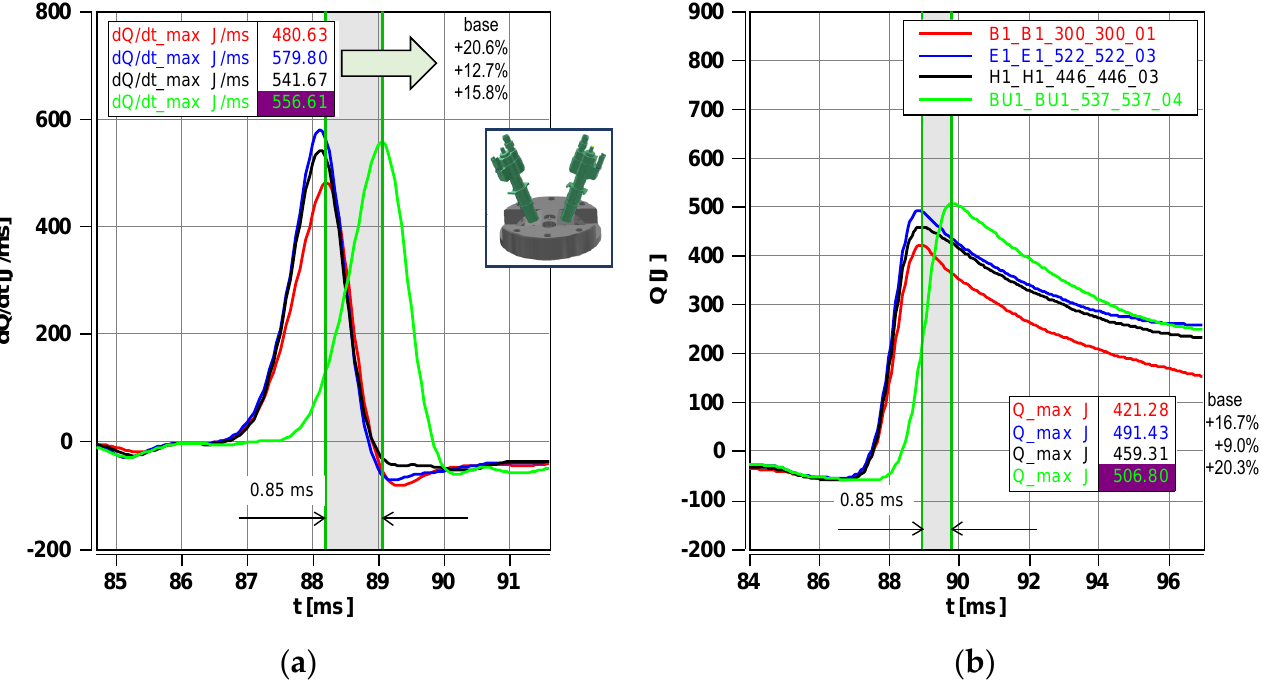
Figure 11. Combustion process indicators (for the injection of various fuels): ( a ) summary of heat release rate characteristics in the combustion chamber of a rapid compression machine during the combustion of one type of fuel supplied by two injectors along with the maximum values for each of the test cases; ( b ) summary of heat release characteristics in the combustion chamber of a rapid compression machine during the combustion of one type of fuel supplied by two injectors along with the maximum values for each of the test cases.